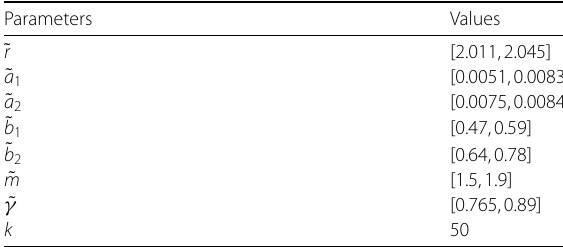
Table 3 The values of different parameters used to simulate the model system in Case-II Parameters